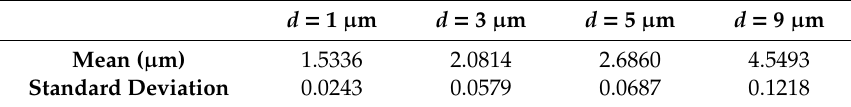
Table 2. Mean and standard deviation of first zero-dispersion wavelength (ZDW).